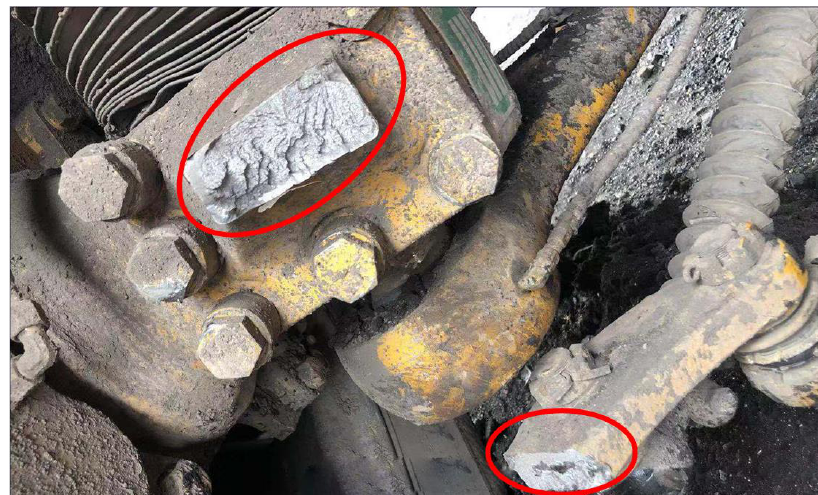
Figure 3. Fractured steering arm.